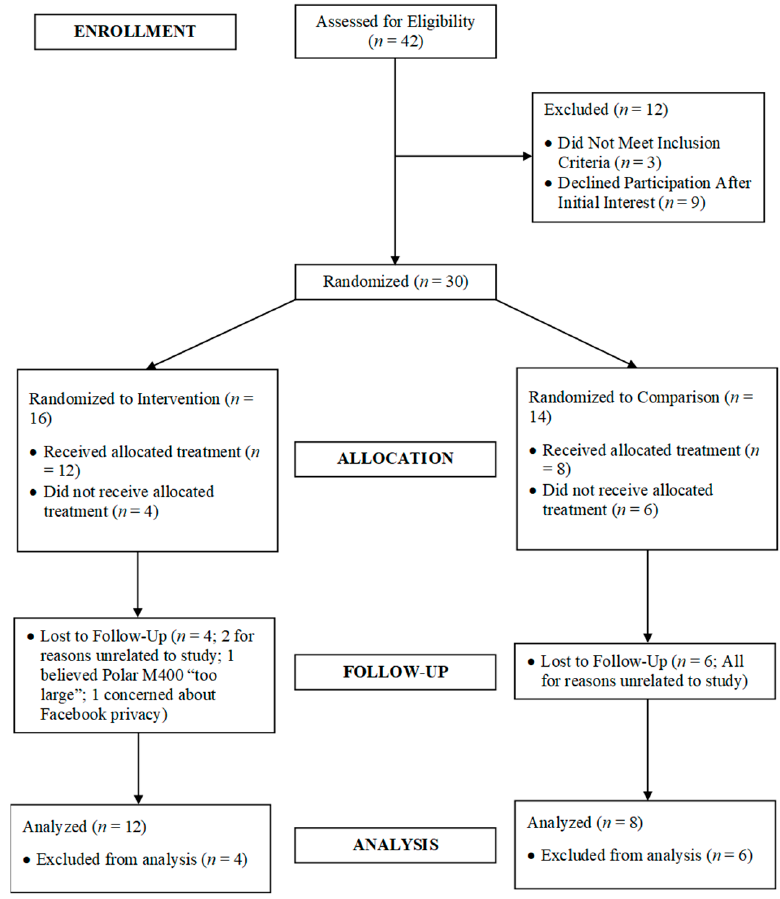
Figure 1. CONSORT study participant flow diagram. Table 1. Participant baseline comparisons for clinical and demographic characteristics